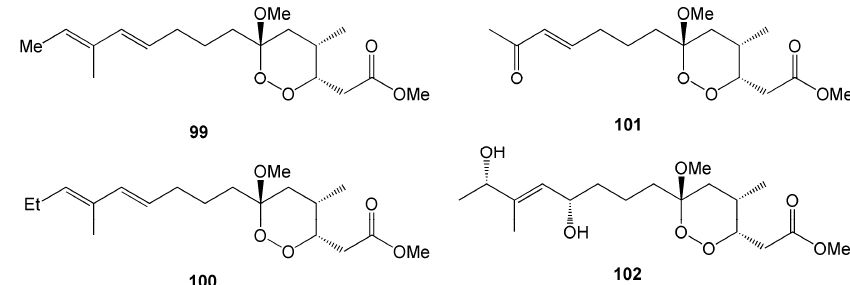
Figure 8. Chemical structures of 99 – 102.